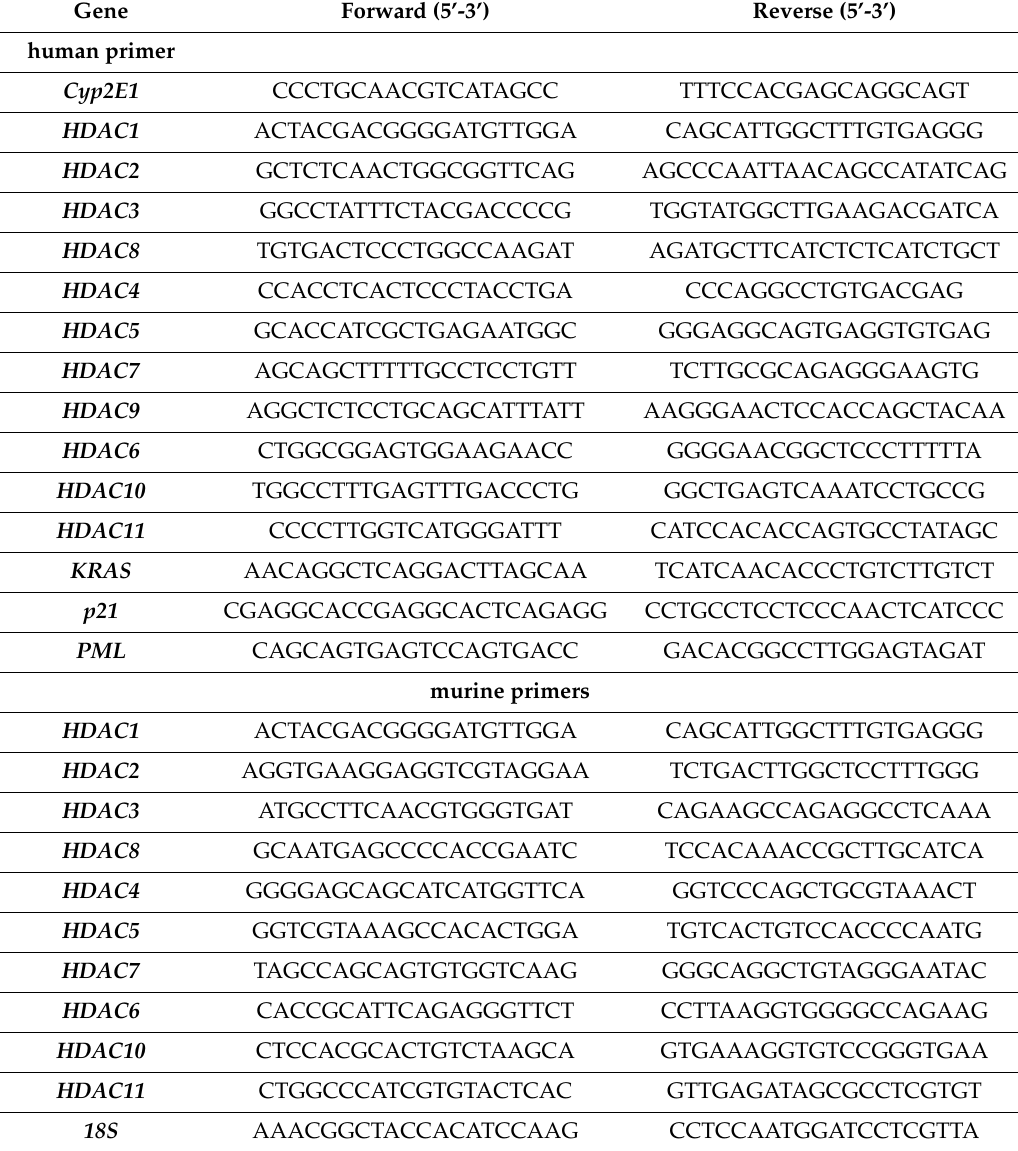
Table 3. Primer sequences for quantitative